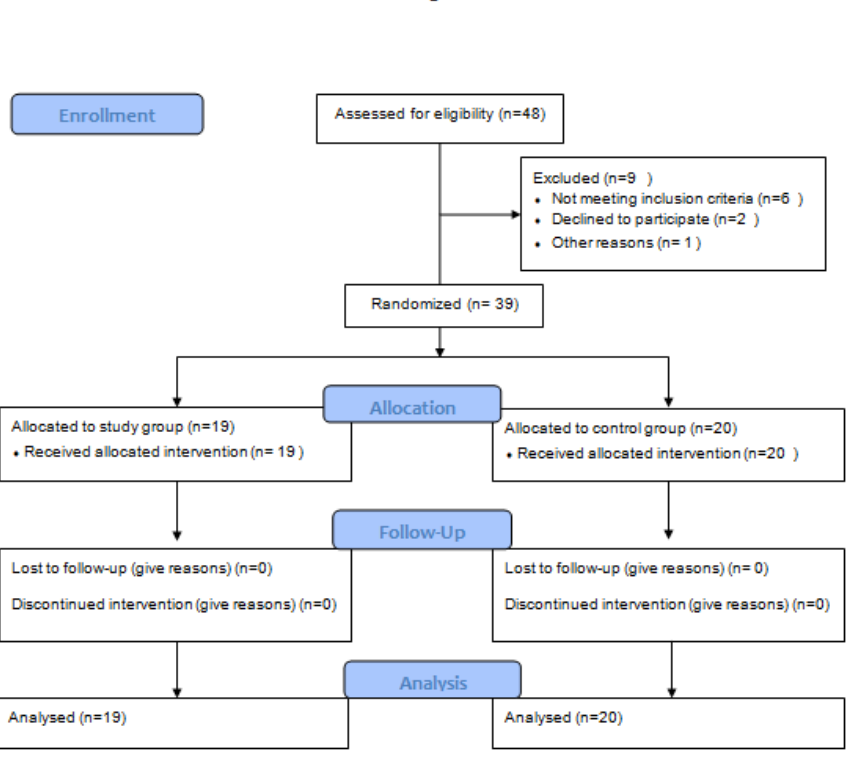
Figure 1. The flow diagram of the of the participants through the